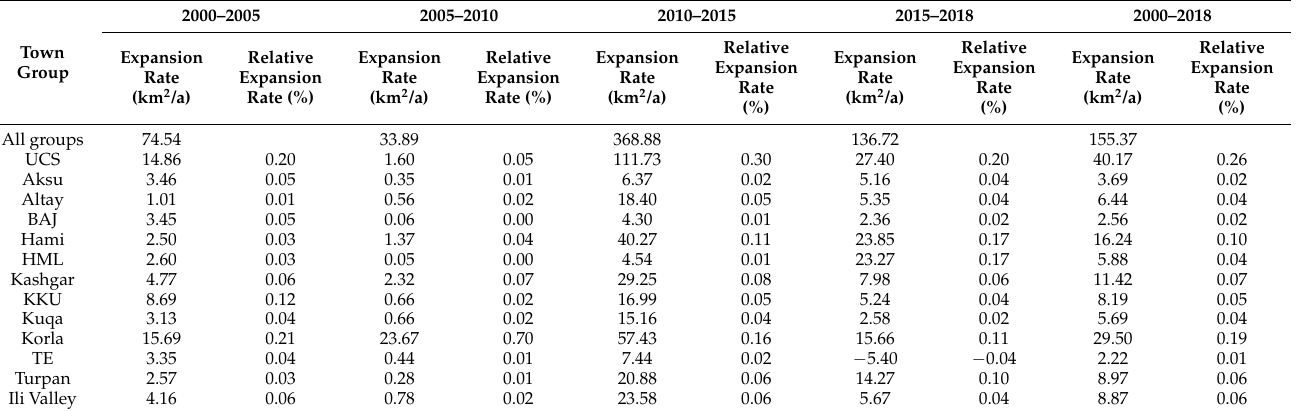
Table 4. Changes in the expansion rate of construction land in the 13 town groups by five study